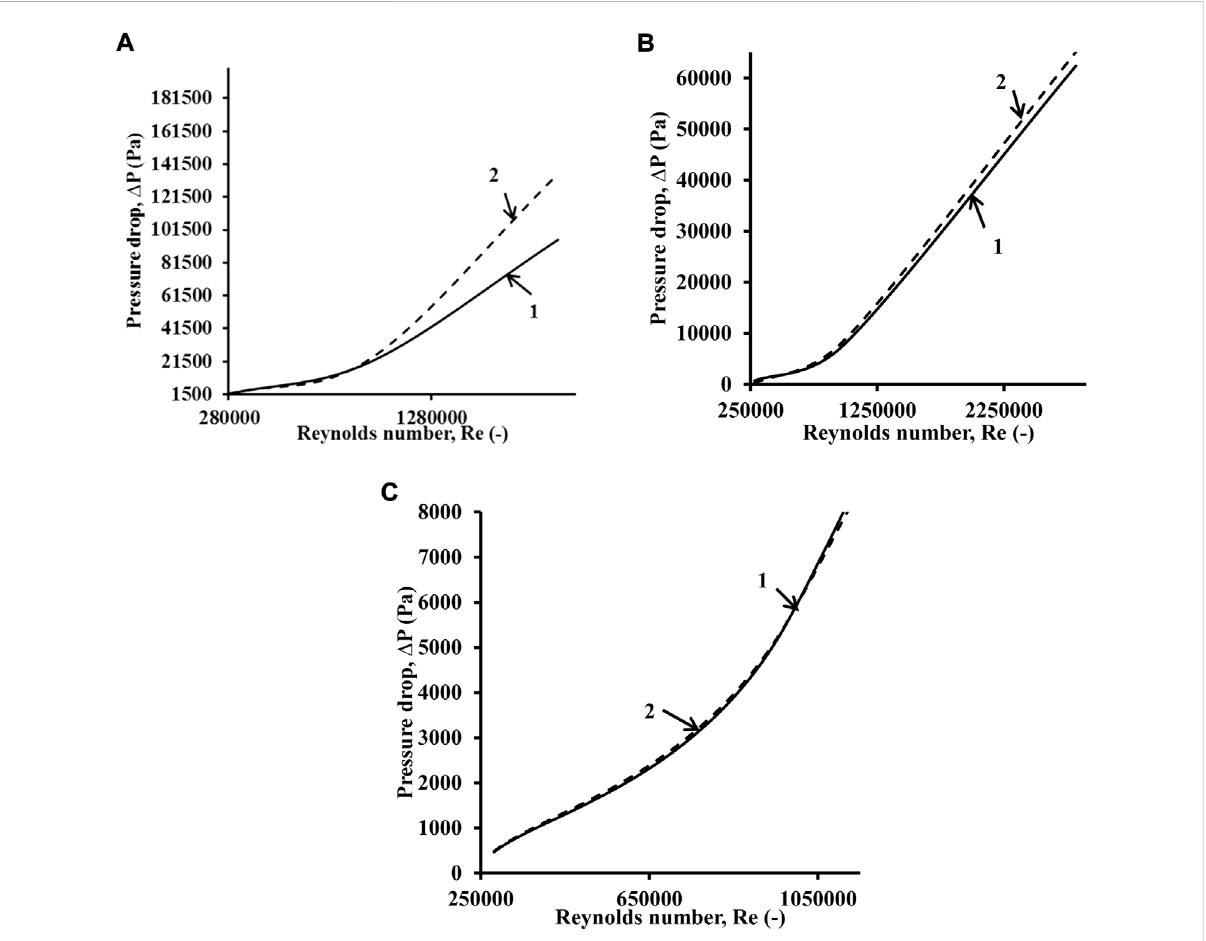
Figure7showsthevelocitycontours(2.82E+05 ≤ Re ≤ 1.91E+06) for a speci fi ed pressure of 10 bar. Figure 7 (A1) shows the velocity contour for fl ow distribution without a distributor for Re = 2.82E+05 and p = 10 bar, while Figure 7 (A2) shows the velocity contour for the same Re number and pressure for the geometry